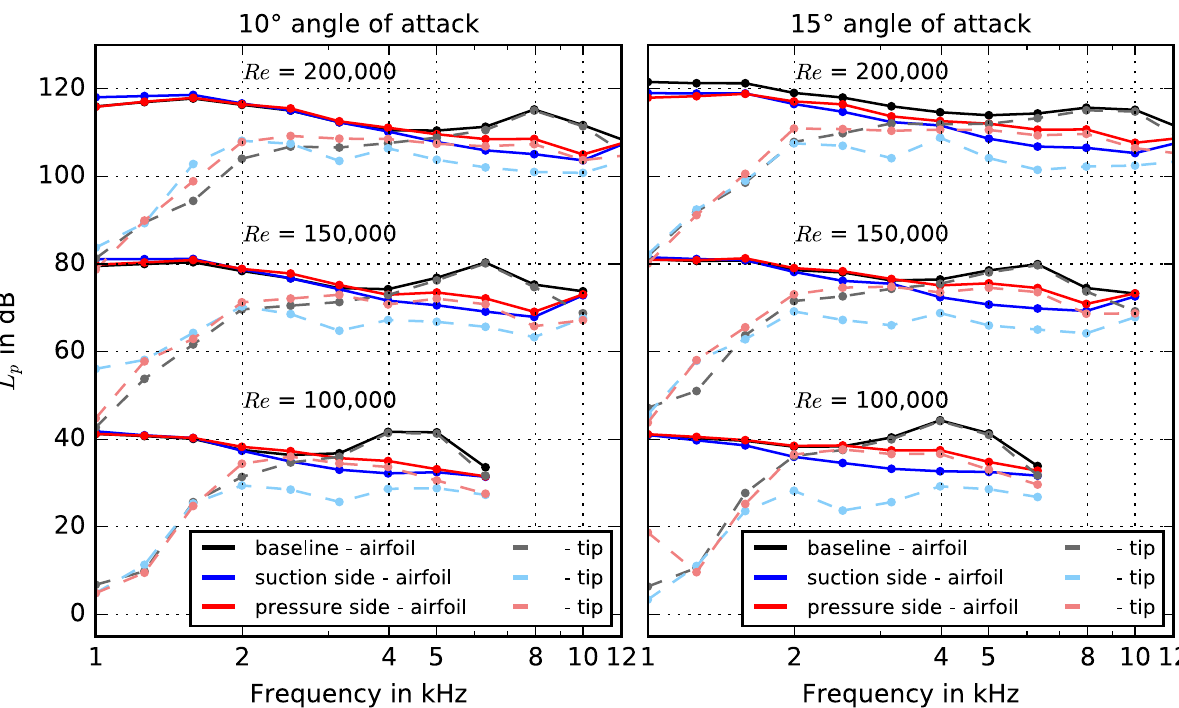
Figure 6. Third octave sound pressure levels integrated over whole airfoil or only the tip region (according to Fig. 3a), between each fl ow speed 30 dB are added to avoid